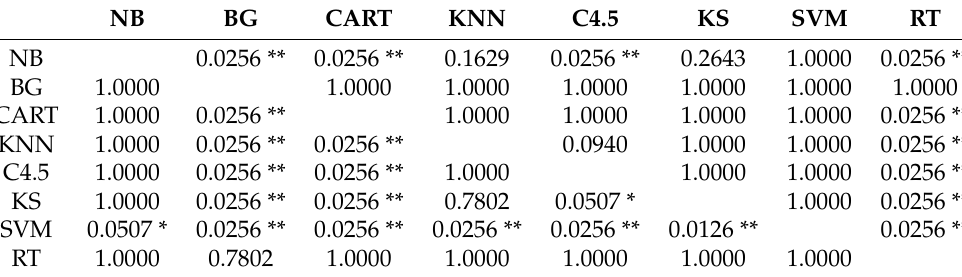
Table 23. Pairwise WSR test for F1-Measure of